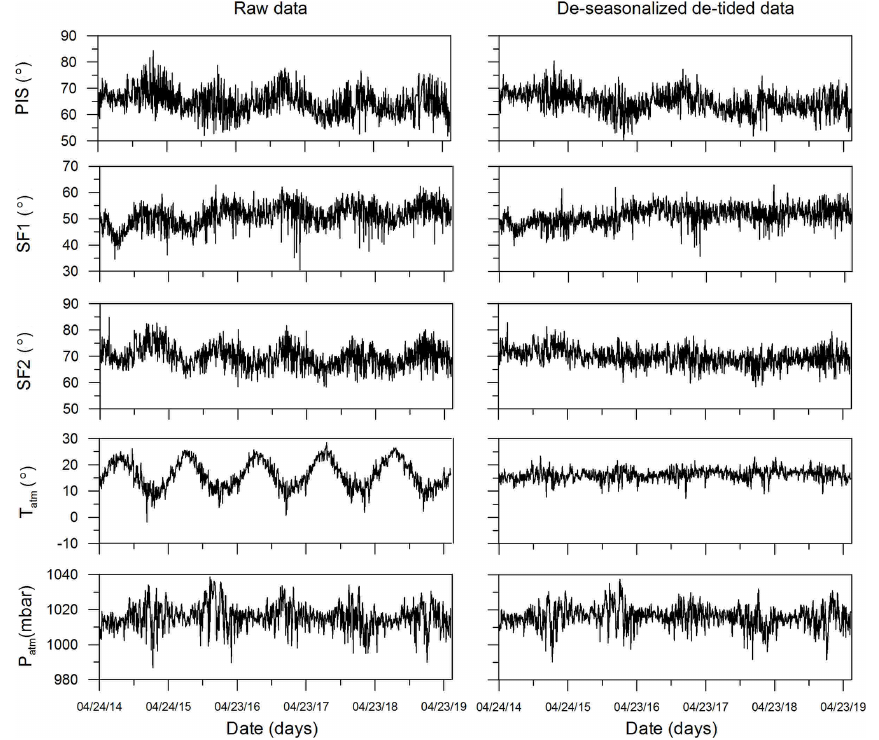
Figure 4. Time-series analysed in this study. On the left we show the raw time-series and on right the time-series corrected from the seasonal and tidal periodicities.